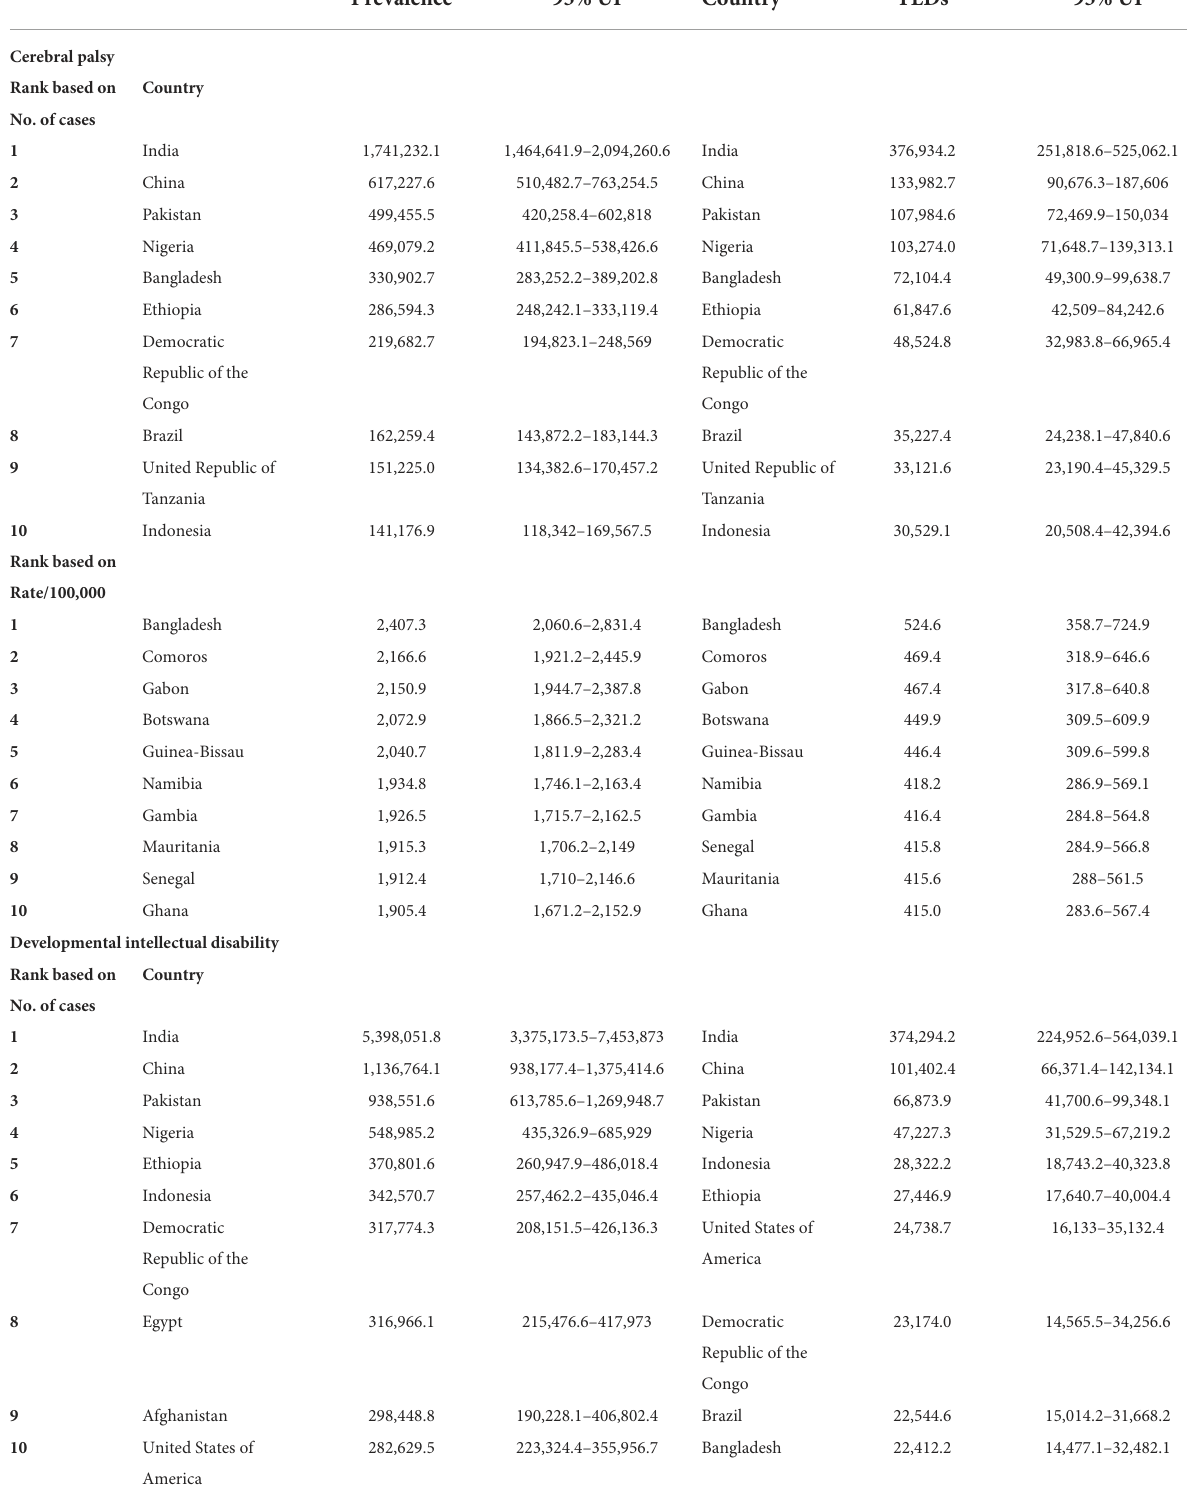
TABLE 2 Ten leading countries based on the prevalence of cerebral palsy and developmental intellectual disability and the YLDs among children under 5 years in 2019. Prevalence 95% UI